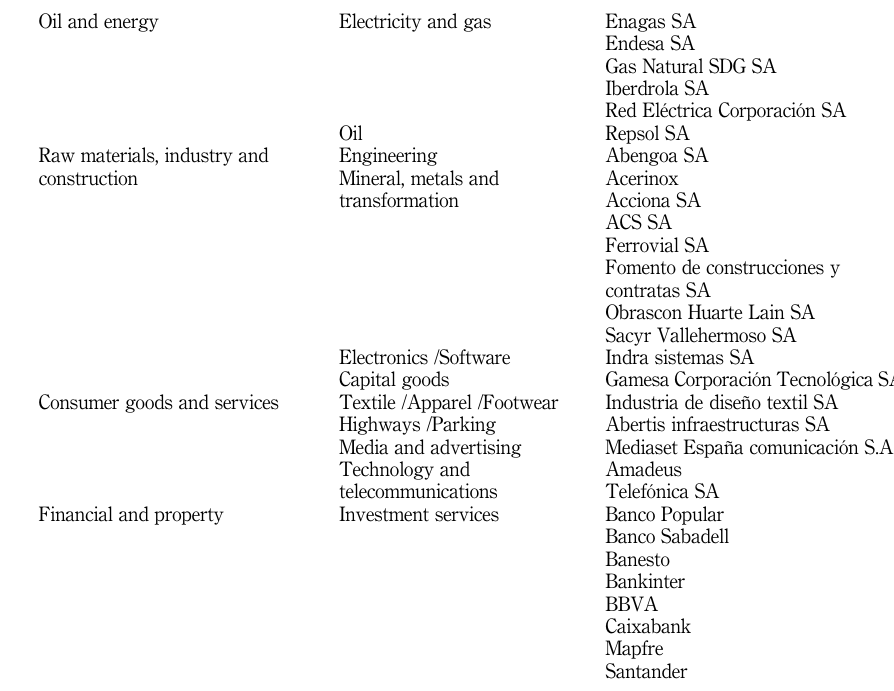
Table II. Ibex-35 companies